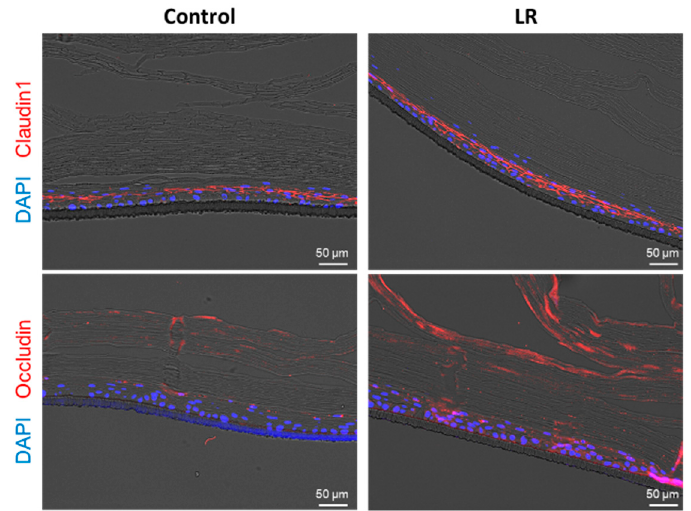
Figure 2. Immunofluorescence images of LR treated Keraskin TM with antibodies against tight junction proteins. Claudin1 (upper red) and occludin (lower red) are stained and DAPI (blue) was used for nuclear staining.